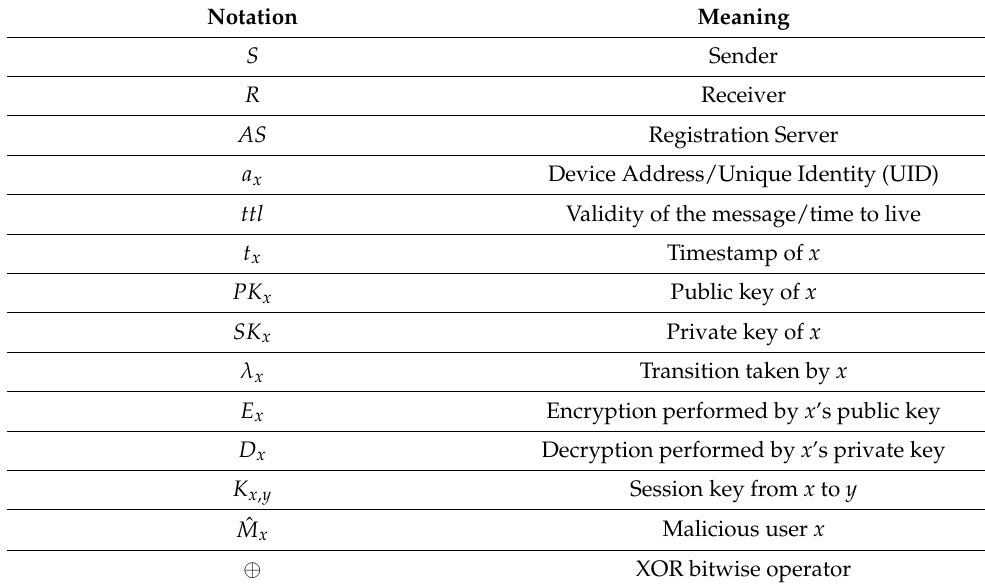
Figure 3. System model. Table 1. Notation.